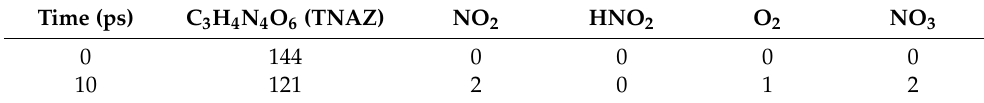
Table 2. Number of TNAZ molecules and other small molecules in the [010] direction.